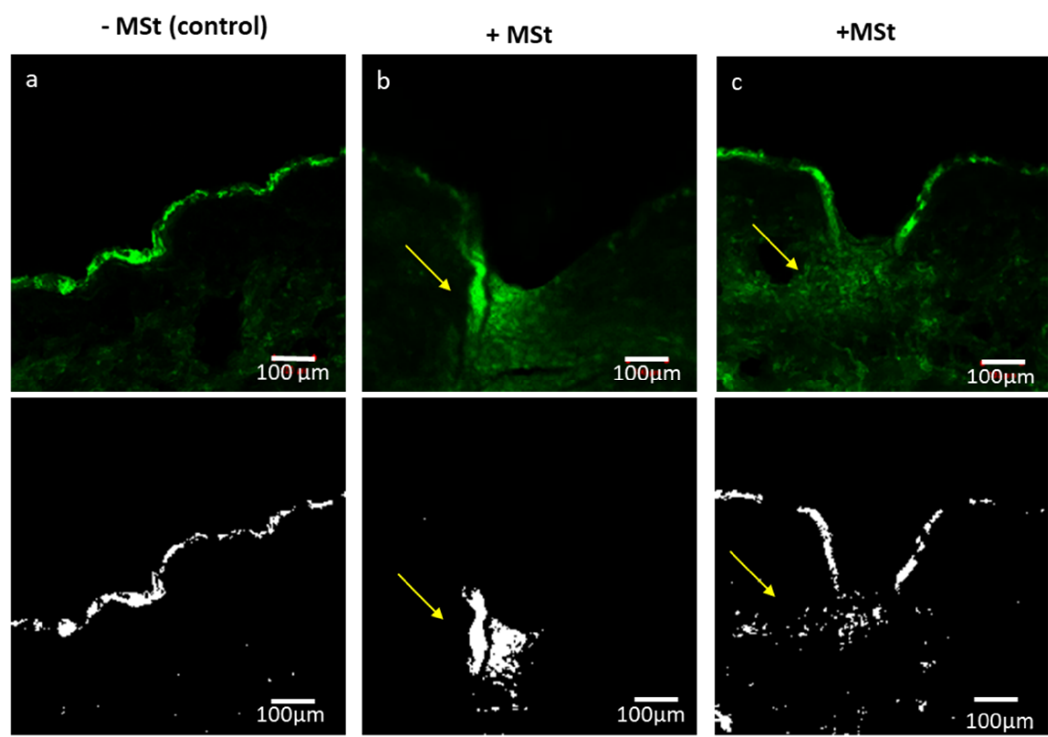
Figure 4. LSCM images of human skin treated with F-HA histological analyses show: ( a ) control sample where FITC-HA was applied without microstructure treatment and remained at the surface of the skin, in comparison to the diffusion of the FITC-HA (MW = 800 kDa) into the deeper layers of excised human skin samples, in the vicinity of the microchannels created by microstructure application ( b , c ). (Yellow arrows indicate the diffusion of HA into deeper skin layers using MSts. Skin is auto-fluorescence (green intensity); however, the intensity of FITC-HA is higher compared to the skin background. The black and white images have background fluorescence removed and show diffusion of HA into the deeper layers of skin samples using microstructures. Scale bar = 100μm.